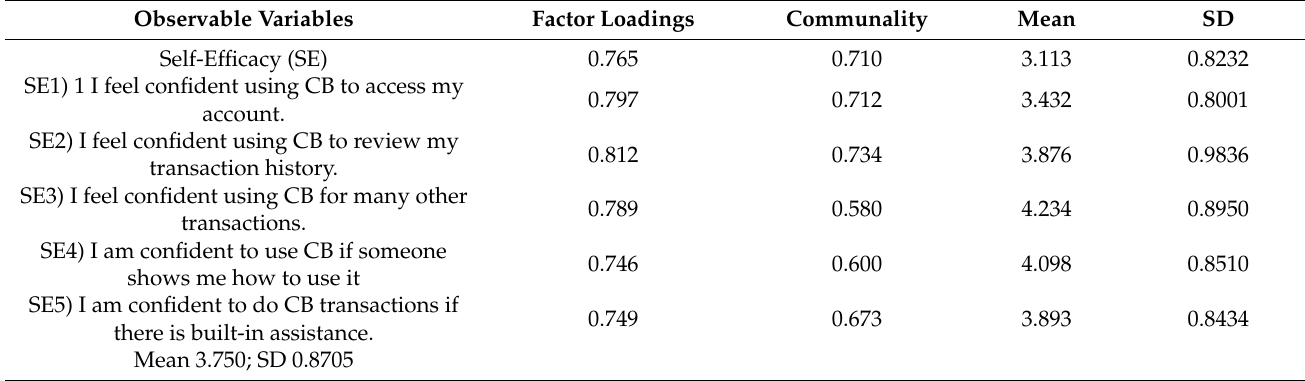
Table 6. Results of varimax rotation (factor loadings of observable